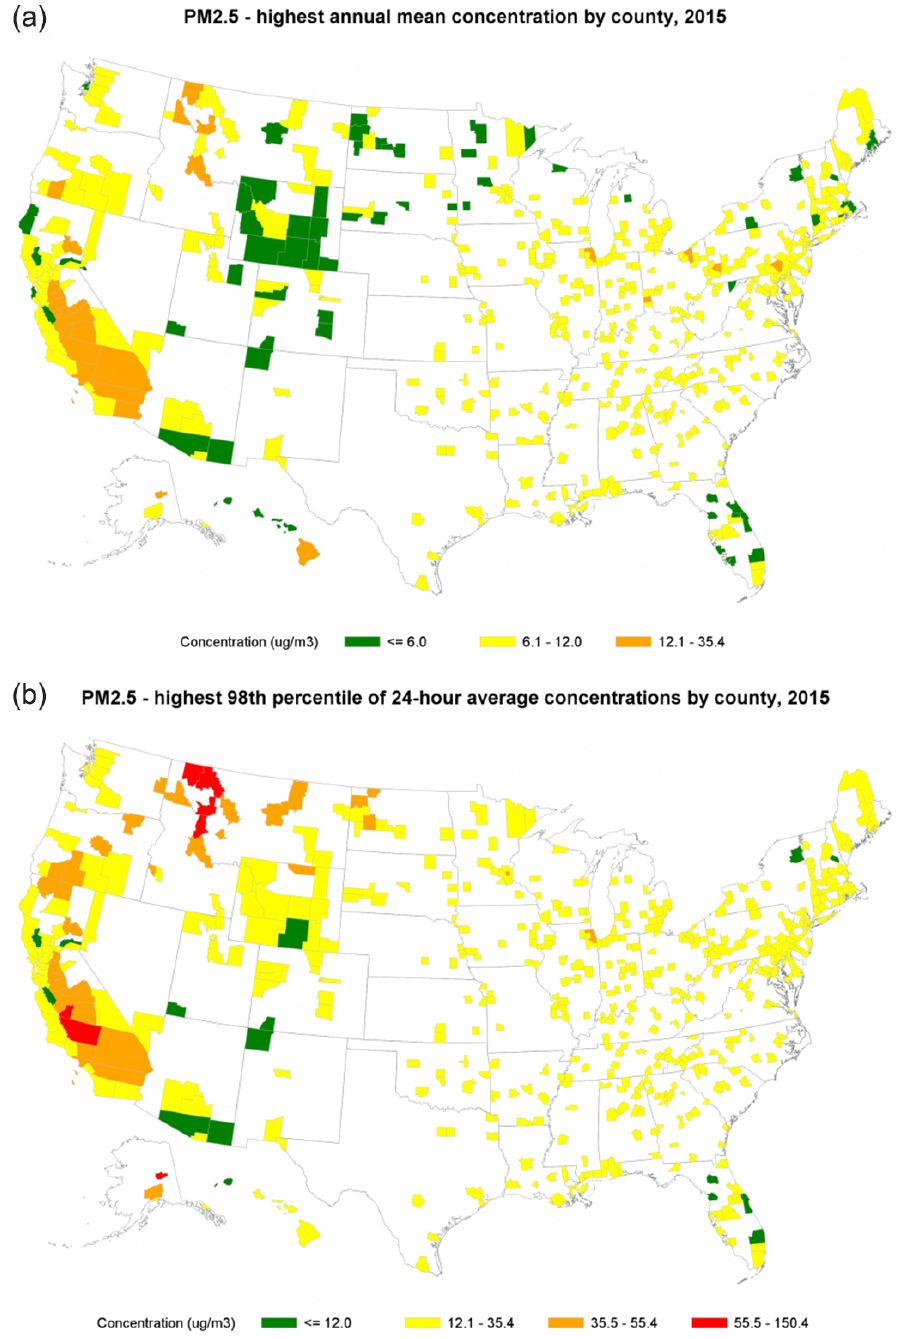
Figure 1. (a) Annual average PM 2 . 5 (24h average) by county as observed for 2014 (source: EPA: “What is particle pollution and what types of particles are a health concern?”; https://www.epa.gov/pmcourse/what-particle-pollution, last access: 1 October 2019). The original description reads as follows: “US counties with high annual mean particle pollution concentrations in 2015. This map depicts fine particle pollution concentrations by US county for 2015 based on long-term (annual) average concentrations. The map’s color key is based on categories of the Air Quality Index (AQI) (see Patient Exposure and the Air Quality Index). All orange and red areas exceeded the annual ambient air quality standards for fine particle pollution during 2015.” (b) The 98th percentile concentrations by count for 2014 from the same source. The original description reads as follows: “All orange and red areas exceeded the 24h ambient air quality standards for fine particle pollution during 2015. The map illustrates how likely it may be for a particular area to experience air quality advisories for particle pollution based on short-term averaging.” The San Joaquin Valley comprises the area in red and the adjoining counties to the northeast and southwest; details are shown in later